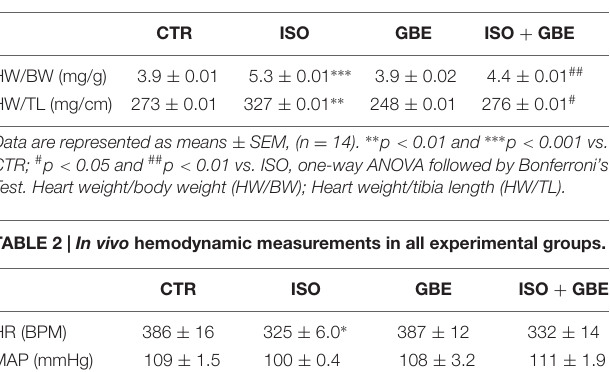
TABLE 1 | Biometric parameters in all experimental groups.